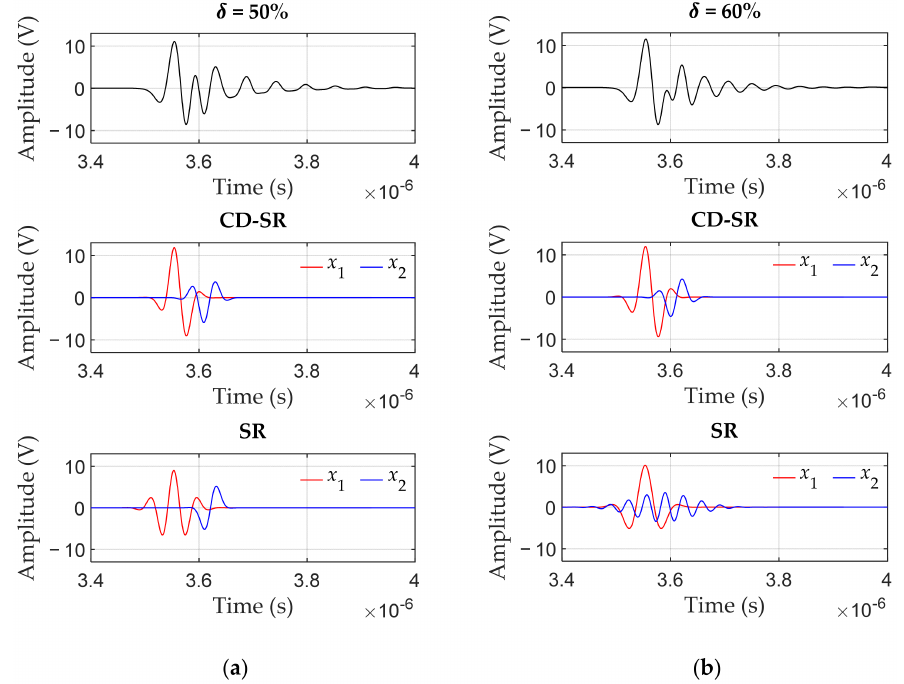
Figure 7. Comparison of reconstructed echoes: ( a ) δ = 50%; ( b ) δ = 60%.